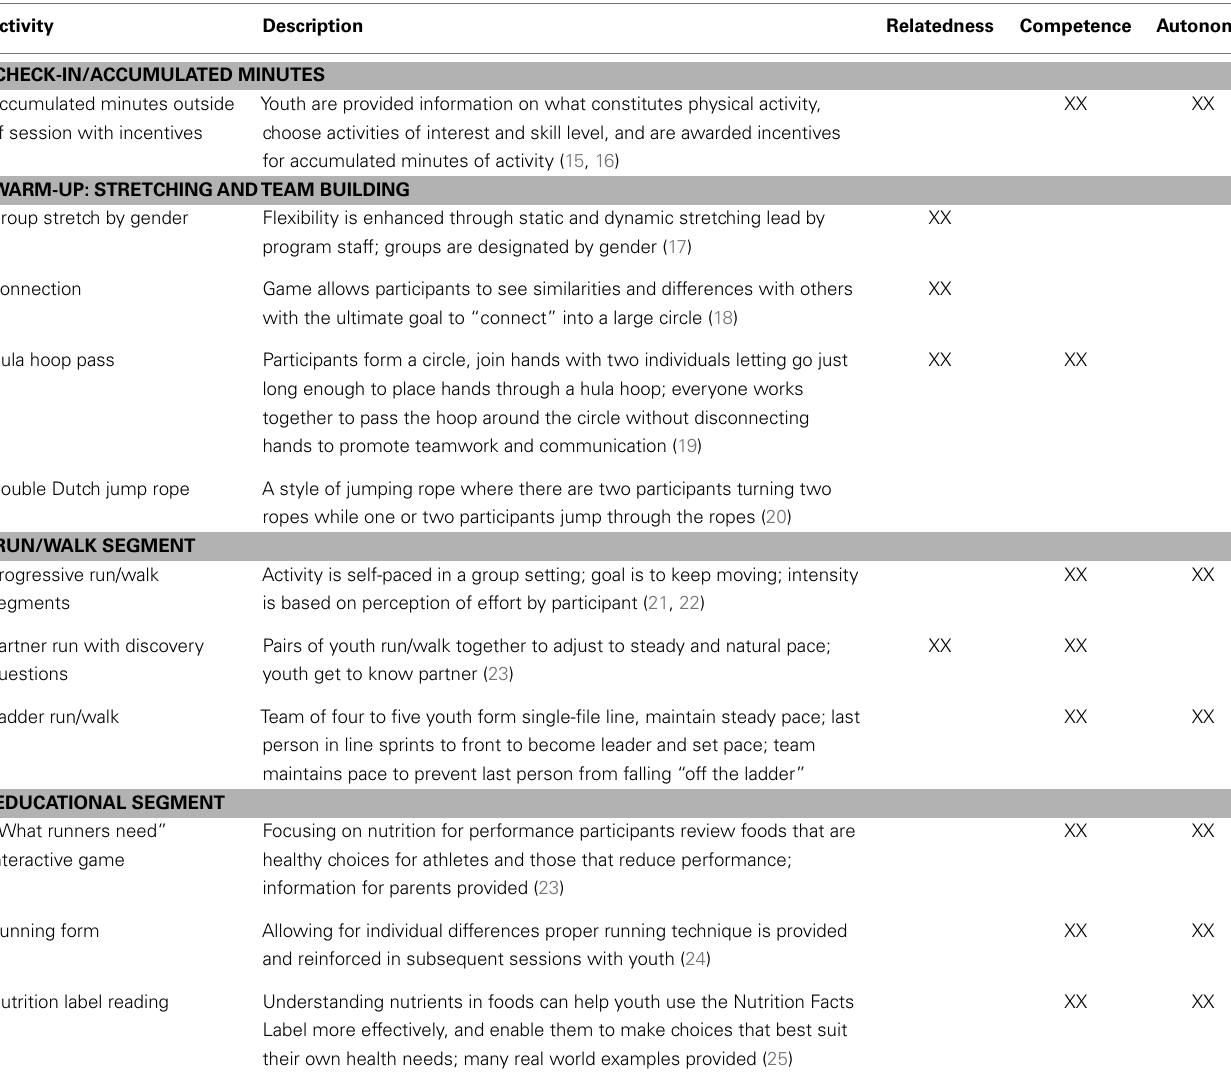
Table 1 | Program activities to promote relatedness, competence, and autonomy.